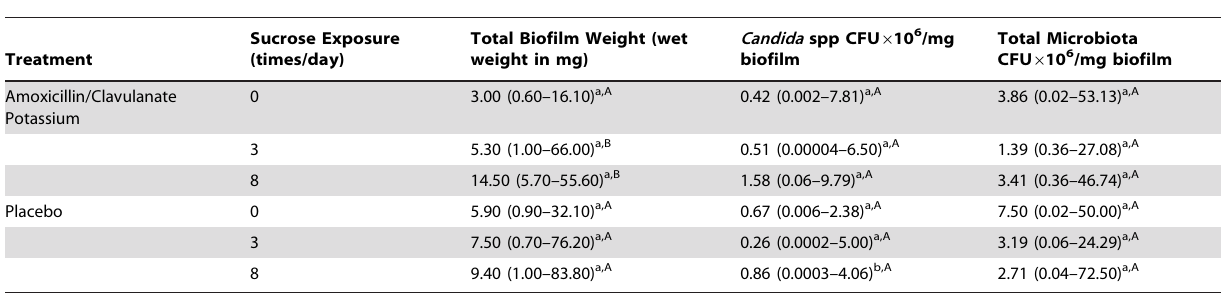
Table 1. Total biofilm weight and microbiological colony count of total microbiota and Candida spp. according to treatments (amoxicillin/clavulanate potassium or placebo) and daily frequency of sucrose exposure (0 – no exposure; exposure – 3 or 8 times/ day).